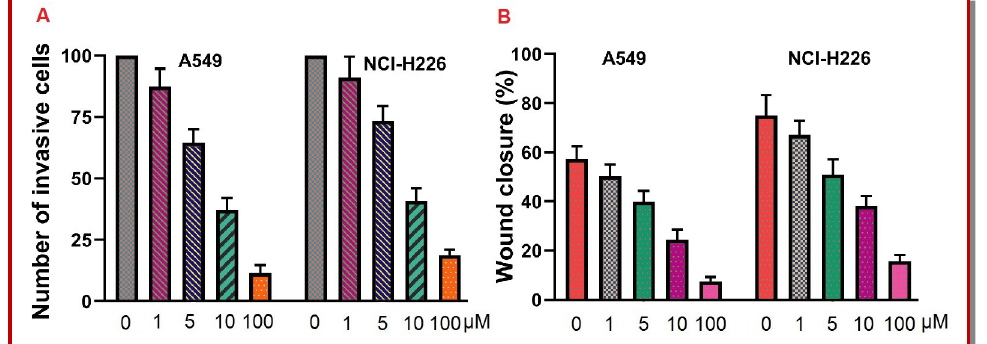
Figure 2: Effects of mulberrofuran G on the invasion and migration of A549 cells and NCI-H226 cells. (A) Transwell invasion as- say; (B) Scratch assay A